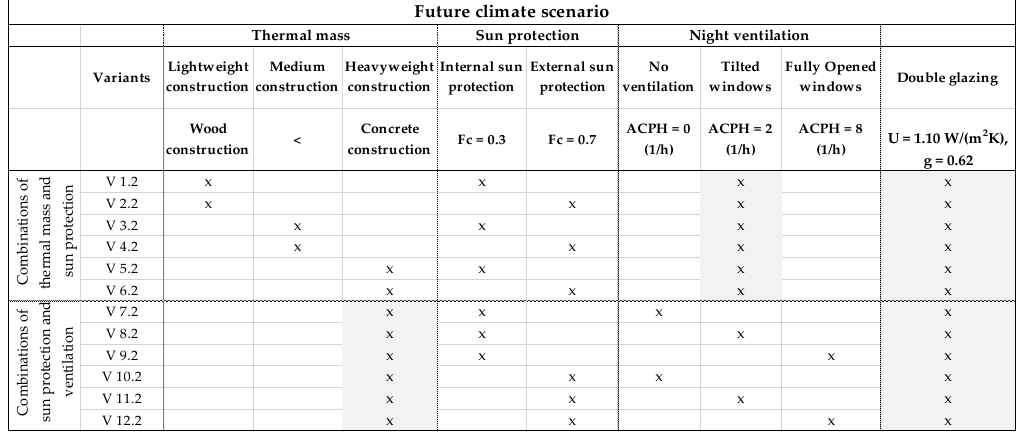
Table 3. Examined variants and boundary conditions for the current and future climate